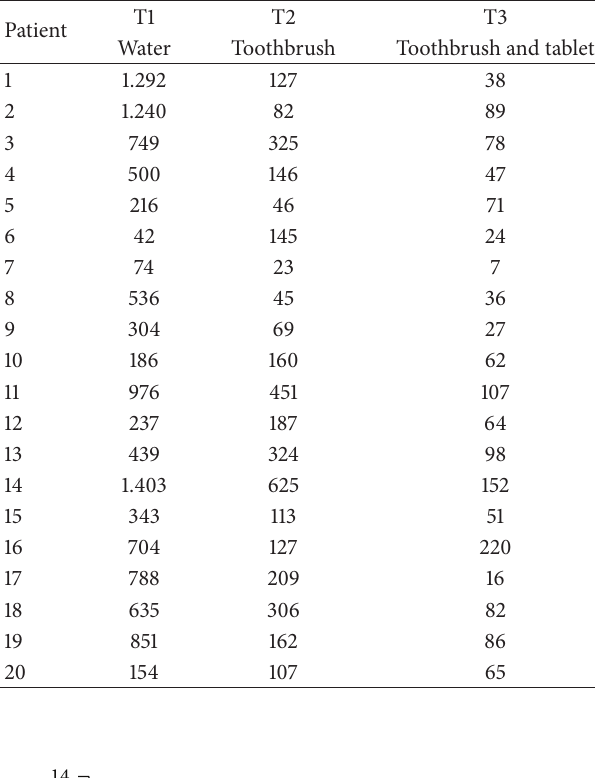
Table 1: Value of the bioluminometer analysis; concentration value is expressed in RLU (relative light units).